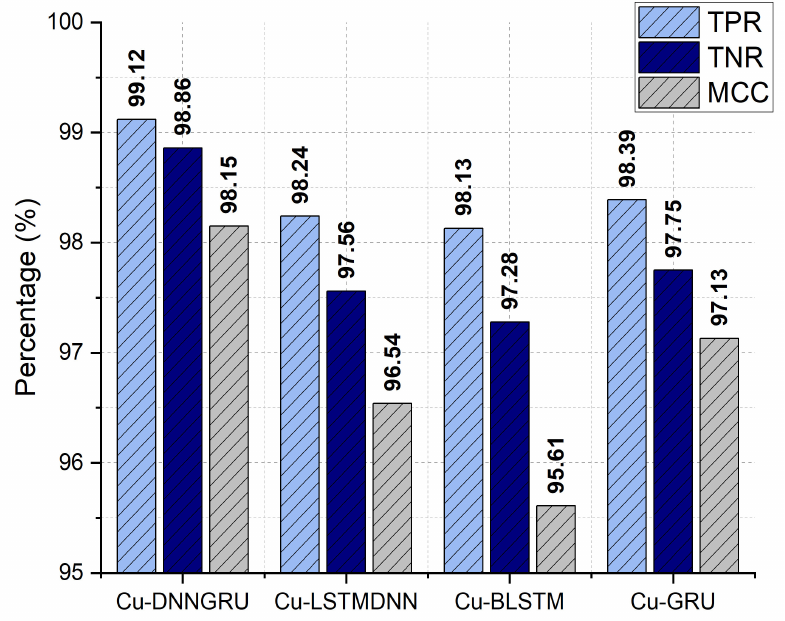
Figure 5. TPR, TNC, and MCC